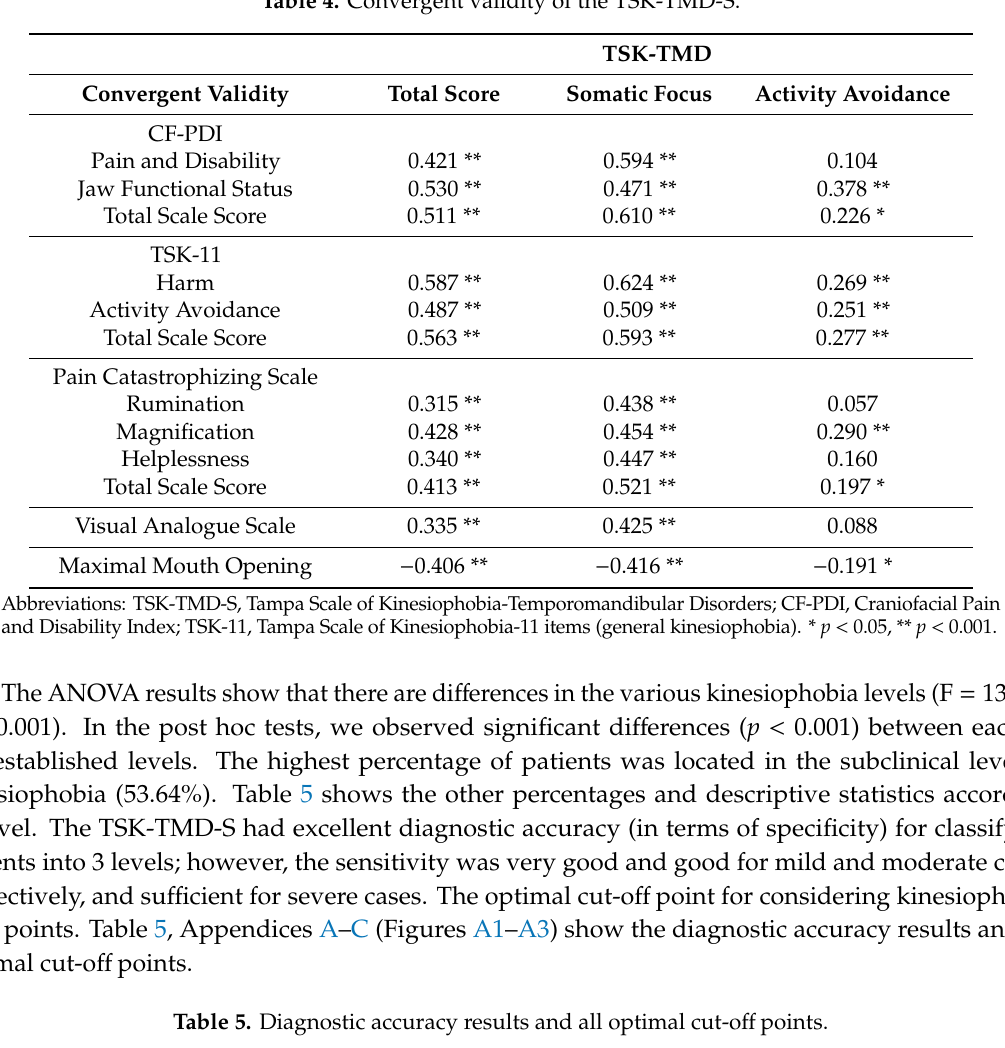
Table 4. Convergent validity of the TSK-TMD-S.